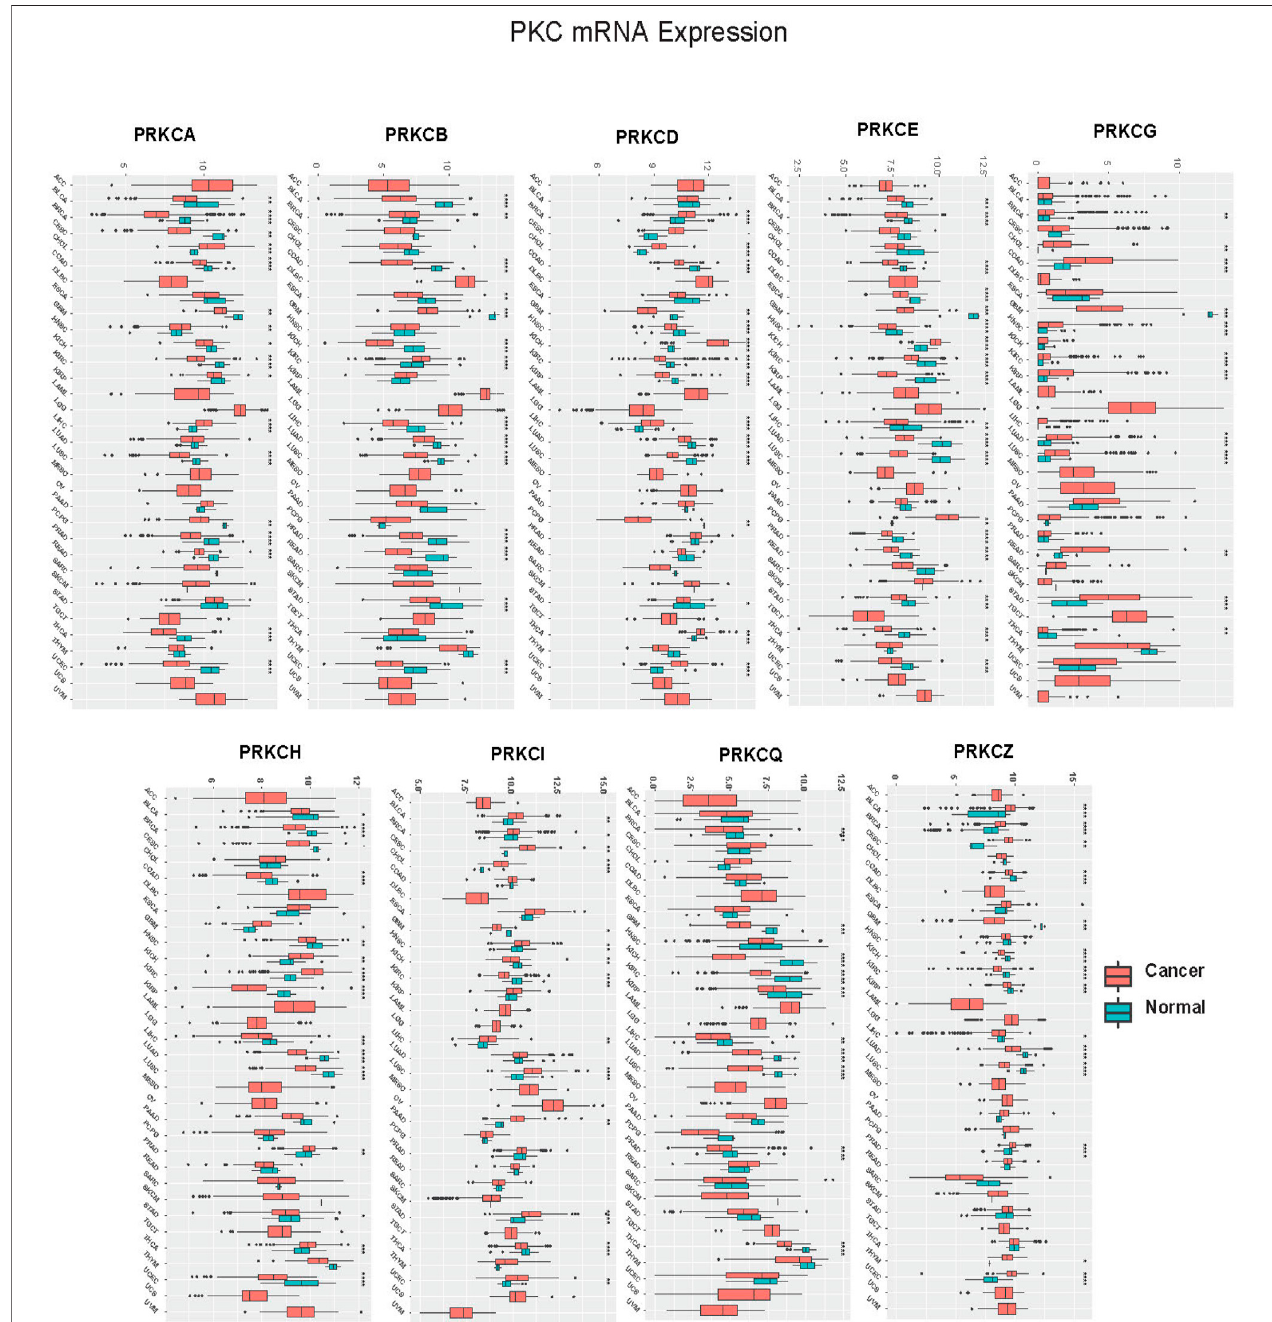
FIGURE 1 | Pan-cancer analysis of PKC mRNA levels between Cancer and Normal in TCGA cancers. *: p -value < 0.05; **: p -value < 0.01; ***: p -value < 0.001.